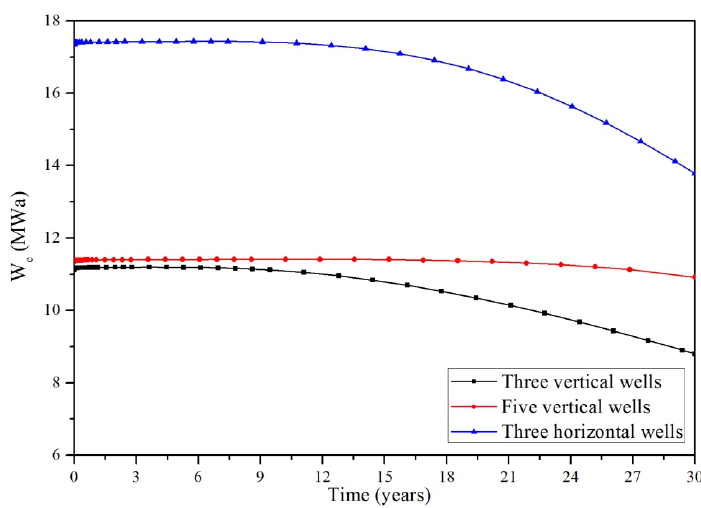
Figure 6. The change of production temperature versus time under different well layouts. In the calculation of the electric power in Equation (4) at Gonghe Basin geothermal field, the heat rejection temperature is T 0 = 4.1 ◦ C = 277.25 K [37]. Figure 7 shows the change of the electric power versus time under different well layouts. The electric power gradually declines from 11.13 to 8.81 MW via three vertical wells, and it declines from 11.33 MW to 10.92 MW during the 30 years via five vertical wells. The electric power gradually declines from 17.36 to 13.79 MW via three horizontal wells during the 30 years. Figure 7 shows that for reservoirs of the same size of 1000 × 1000 × 500 m, the electric power via three horizontal wells is higher than that via five vertical wells, and the electric power via five vertical wells is higher than that via three vertical wells. Based on Equation (4), main factors influencing the electric power is water production rate q and the production temperature T pro . As stated above, because the sequence of water production rate is three horizontal wells > five vertical wells > three vertical wells, the production temperature difference is very small, thus the electric power is mainly determined by the water production rate, and the three horizontal well system obtains highest electric power and the three vertical well system obtains lowest electric power.